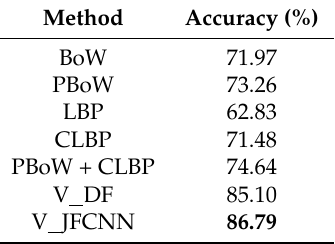
Table 7. Classification accuracies (%) using visual features.